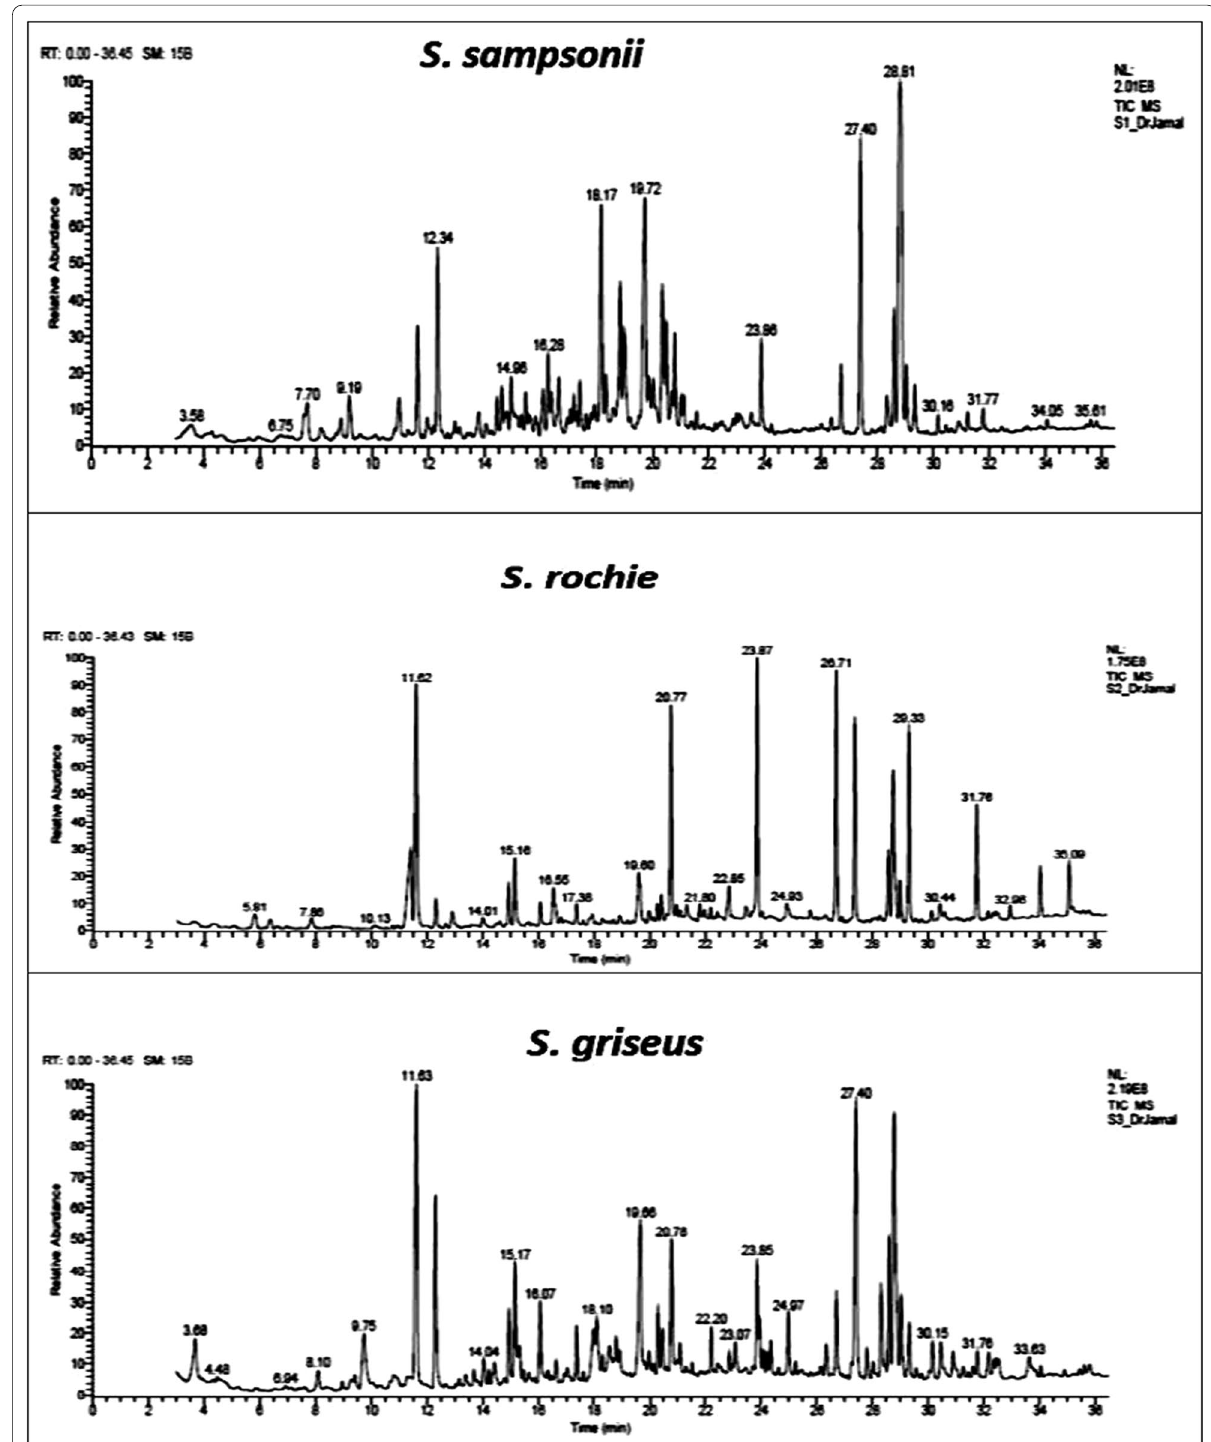
Fig. 2 GC–MS analysis of ethyl acetate extract of three Streptomyces